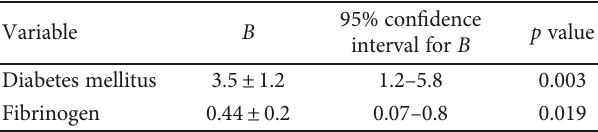
Table 4: Multivariable linear regression